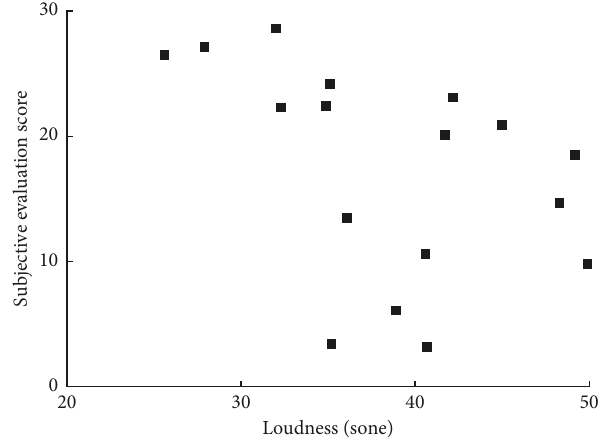
Figure 8: Correlation between loudness and the subjective eval- uation value.